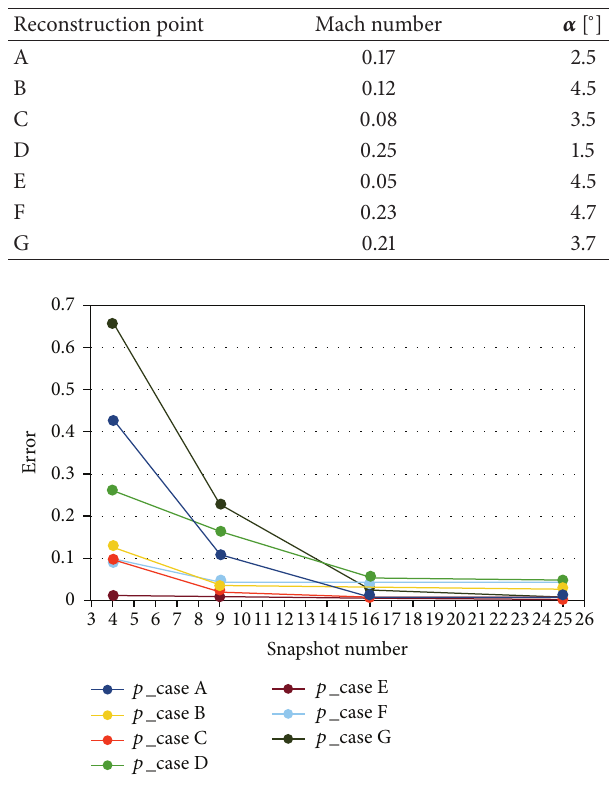
POD coefficients corresponding to parameters not belonging to the initial snapshot